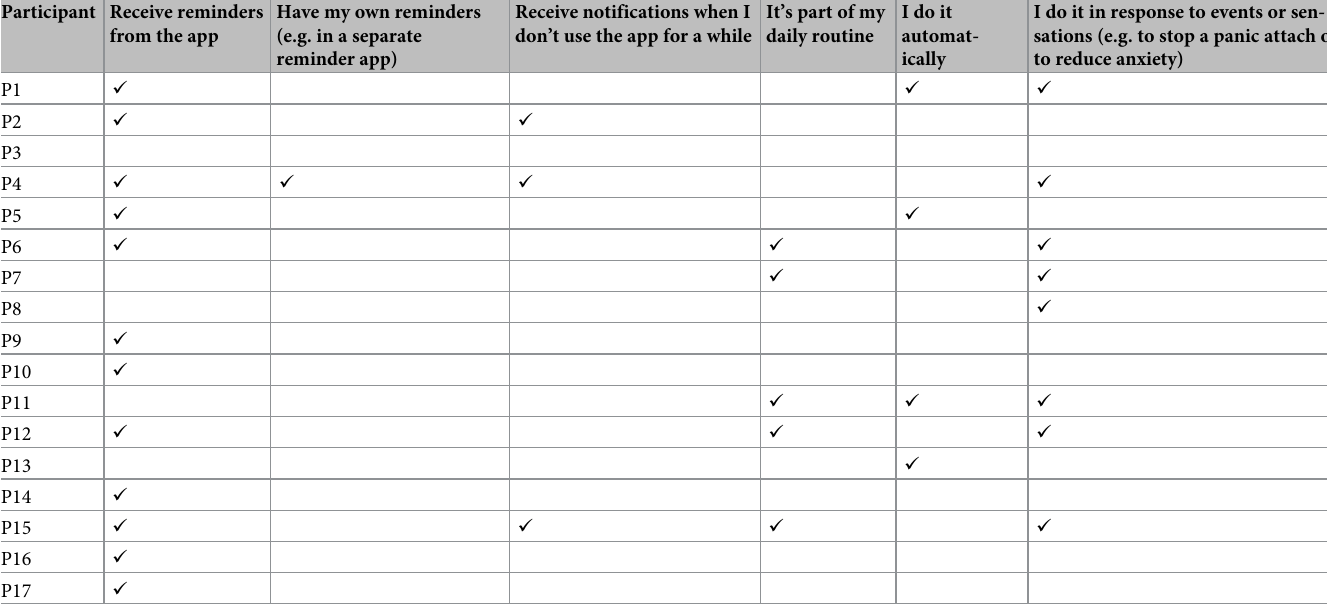
Table 2. Participants reminders for app use. Participant Receive reminders Have my own reminders from the app (e.g. in a